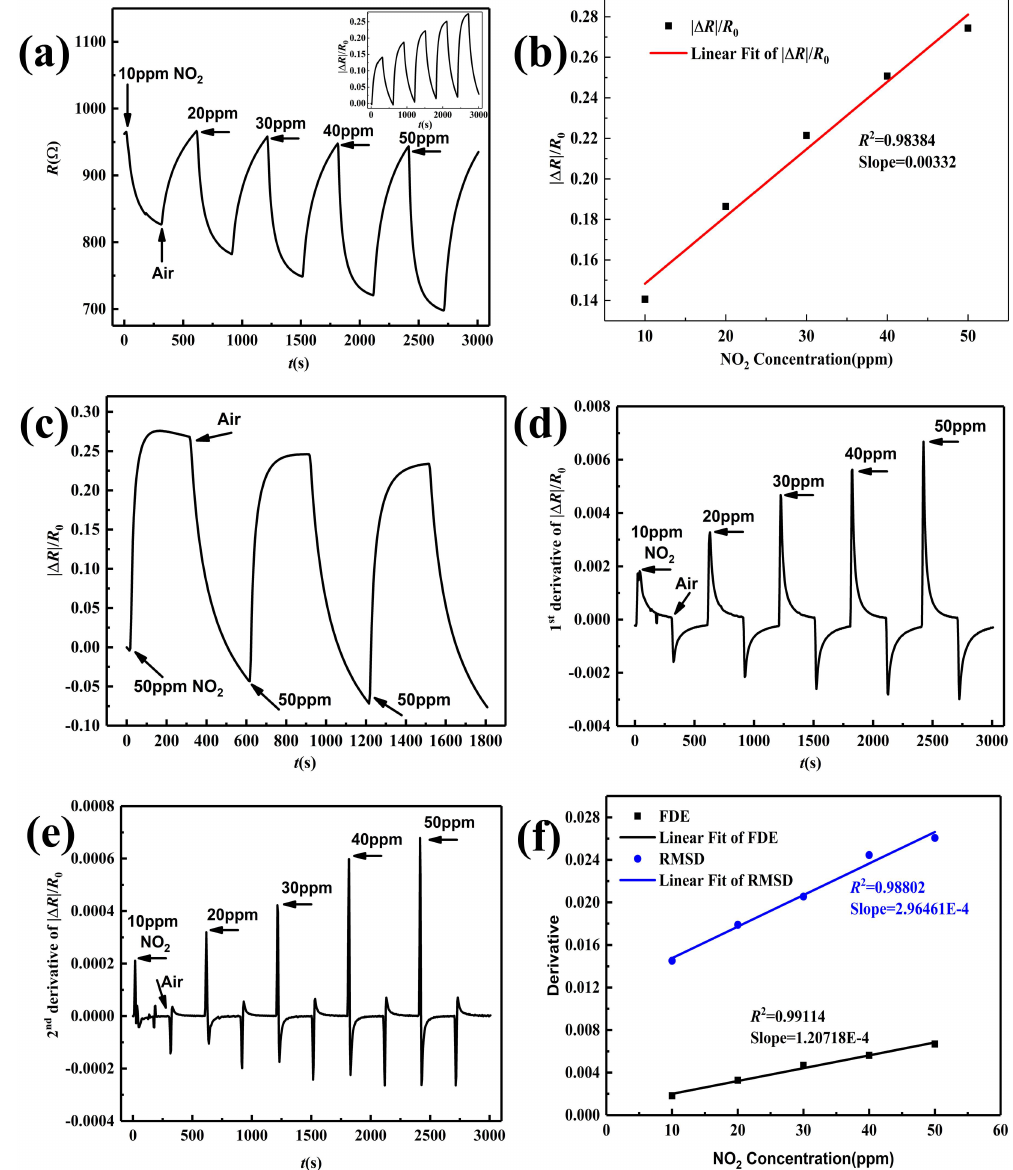
Figure 8. Sensing performance of 5.1%RGO/SnO 2 sensor ( a ) Real-time resistance change and response, ( b ) Sensitive, ( c ) Repeatability, ( d ) first derivative of response, ( e ) second derivative of response. ( f ) linear fit of FDE and